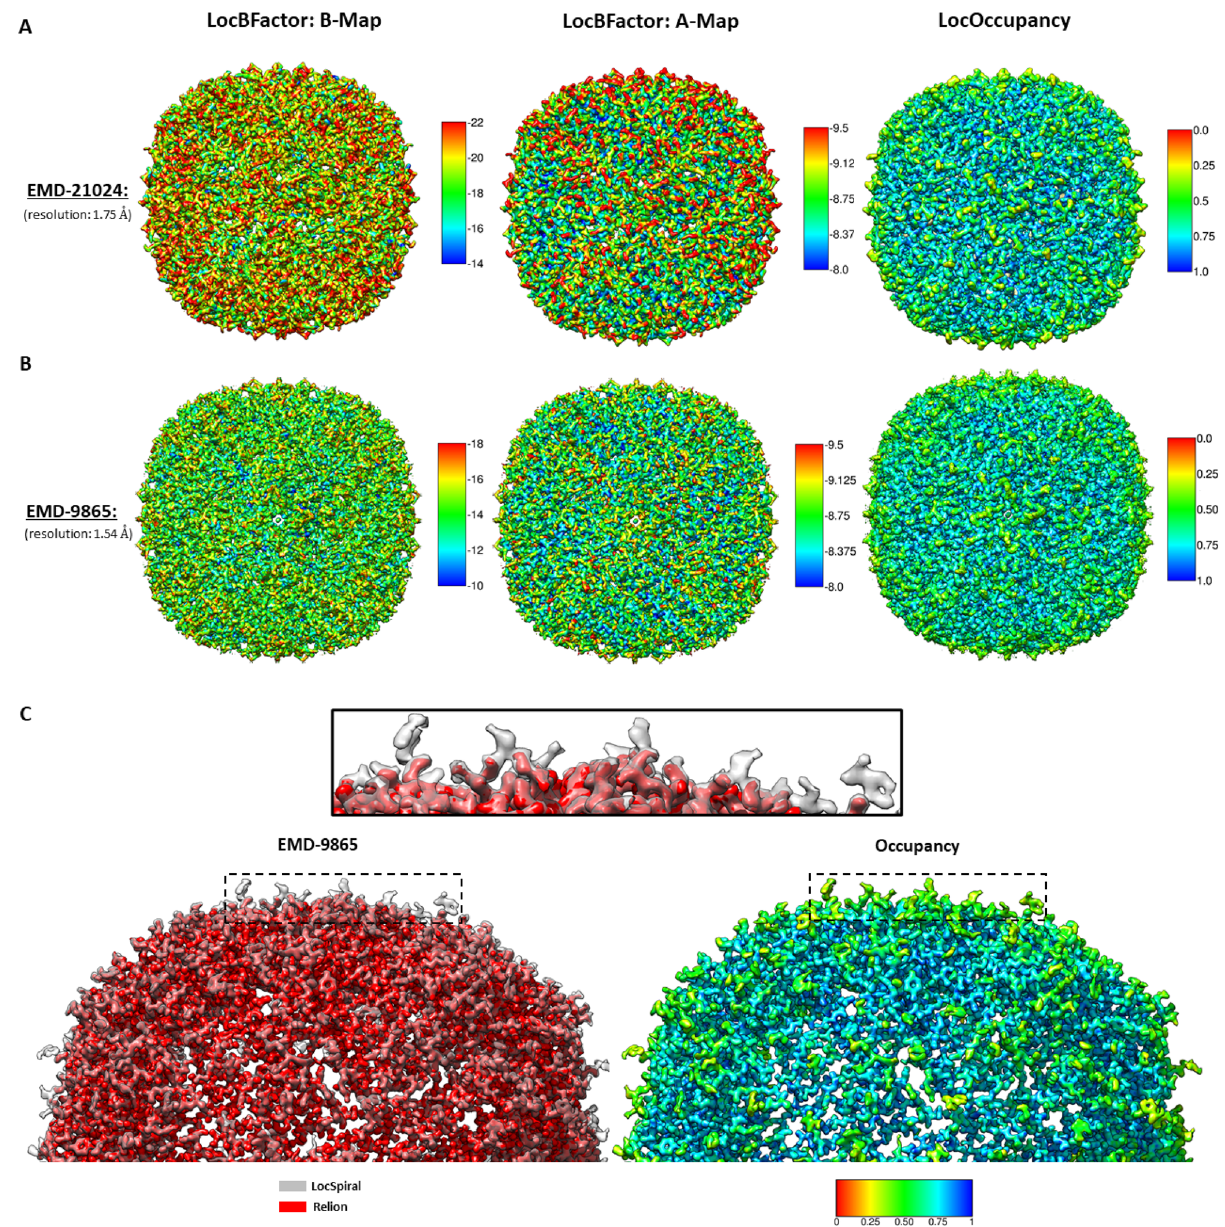
Fig. 3 Results obtained by LocBFactor, LocOccupancy and LocSpiral for apoferritin sample. Obtained B -maps (local B -factor map corresponding to the slope of the local Guinier plots), A-maps (local values of the logarithm of structure factor amplitudes at 15 Å) and occupancy maps by LocBFactor and LocOccupancy for EMD-21024 ( A ) and EMD-9865 ( B ). The B -factor ranges between [ − 22, − 14] Å 2 in A and [ − 18, − 10] Å 2 in B . The A-map ranges between [ − 9.5, − 8.0] in A and B . The occupancy ranges between [0, 1] in A and B . In C , we show on the left side, superimposed sharpened maps obtained by LocSpiral (grey colour) and Relion (red colour) for EMD-9865. The black rectangle shows a zoomed view of the region indicated with the dashed rectangles. On the right, we show the respective occupancy map obtained by LocOccupancy at the same orientation that these sharpened maps. In this fi gure, 0 (red colour) indicates no density occupancy and 1 (blue colour) full